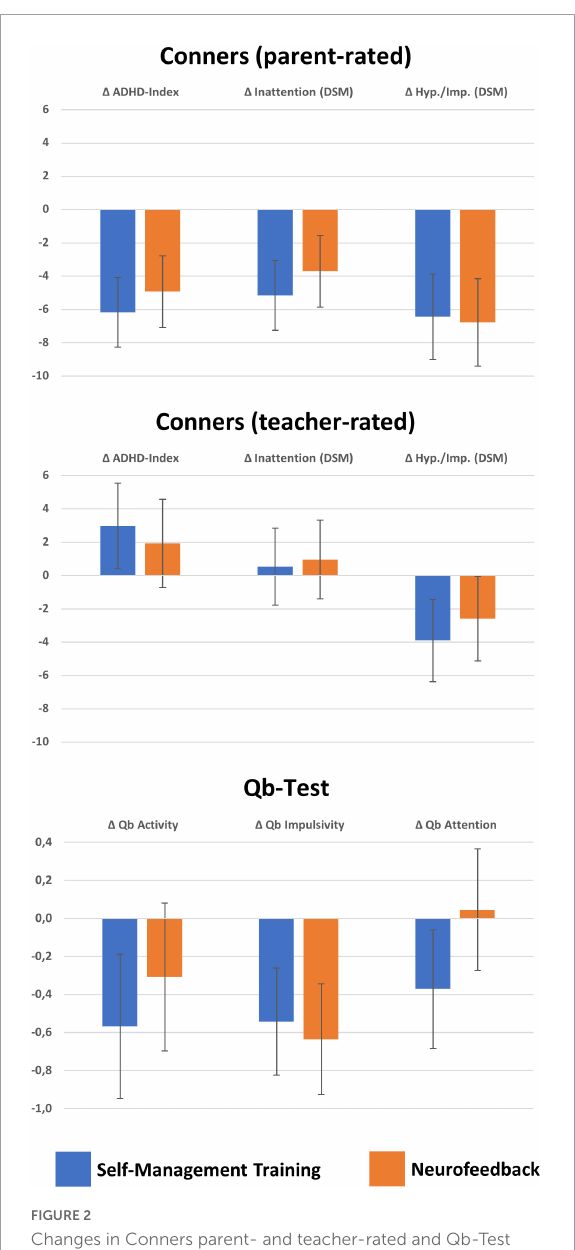
FIGURE2 Changes in Conners parent- and teacher-rated and Qb-Test ADHD symptoms. This figure illustrates means and confidence intervals with p = 0.05 of ADND symptom changes from T1 to T3 from the modified intention to treat (mITT) analysis on imputed missing values. Significant improvements, that is, confidence intervals below zero as indicated by error bars, are in all of the parent-rated Conners scales (above), but in teacher ratings only in hyperactivity/impulsivity. The Qb-Test revealed improvements in particular for SMT for all ADHD symptom scores, but regarding NF only for Impulsivity. No significant differences in (cid:49) change scores between treatments were detected except